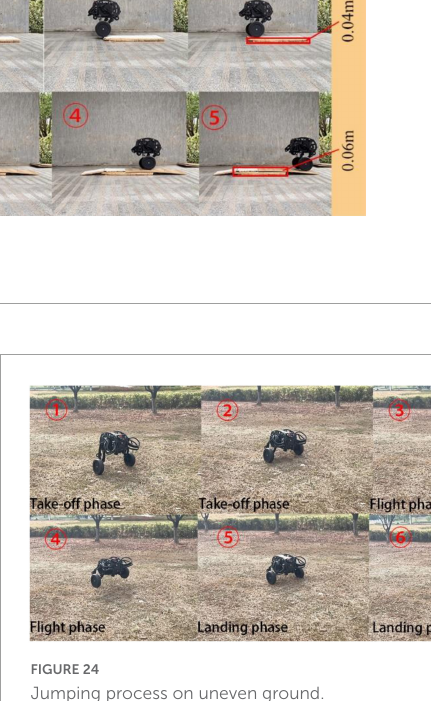
FIGURE24 Jumping process on uneven